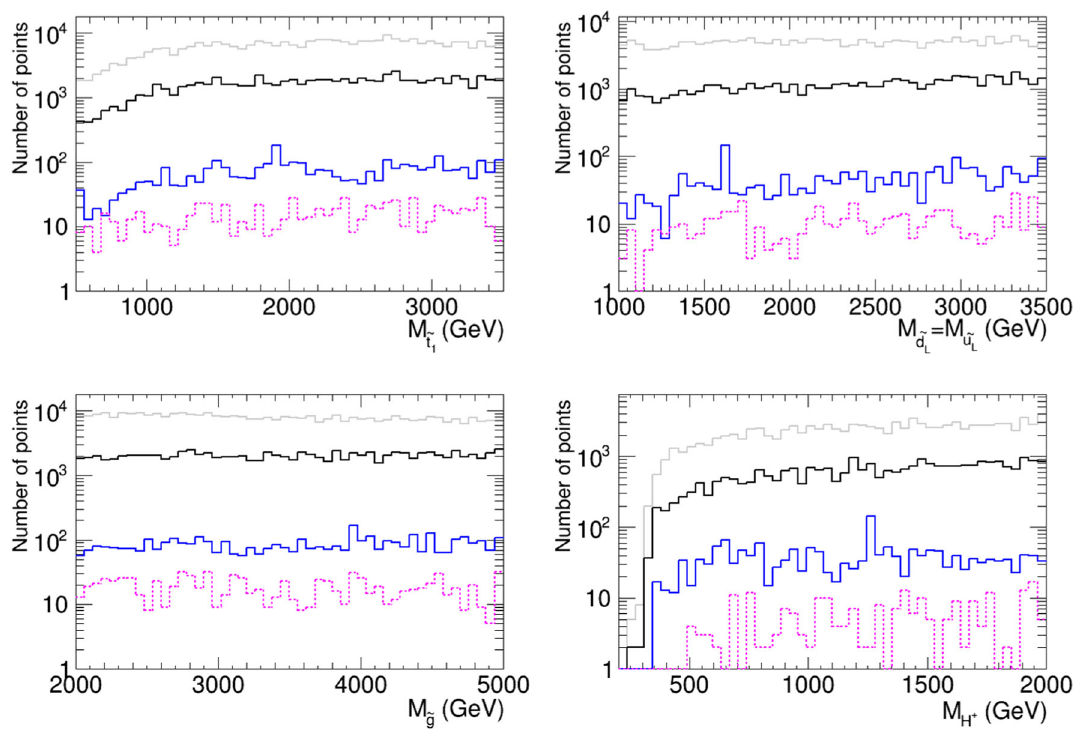
Fig. 1 Distributions of sparticle masses in our scan of the MCPMFV pMSSM. Upper left: The lighter stop mass, upper right: left-handed first- and second-generation squark mass, lower left: gluino mass, lower right: charged Higgs mass. Grey histograms: all points passing the LHC